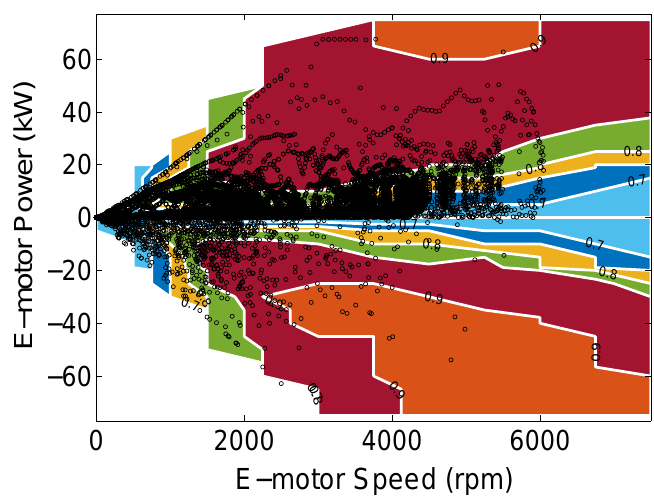
Figure 10. E-motor operating points, shown with ‘ o ’ symbol, plotted over the E-motor efficiency map.